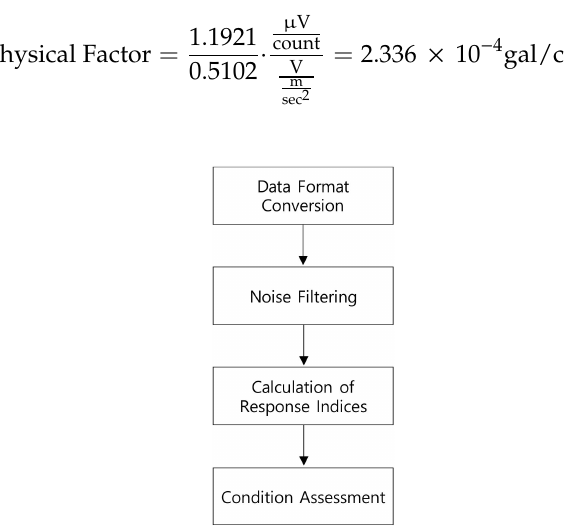
Figure 1. Major processes of the monitoring